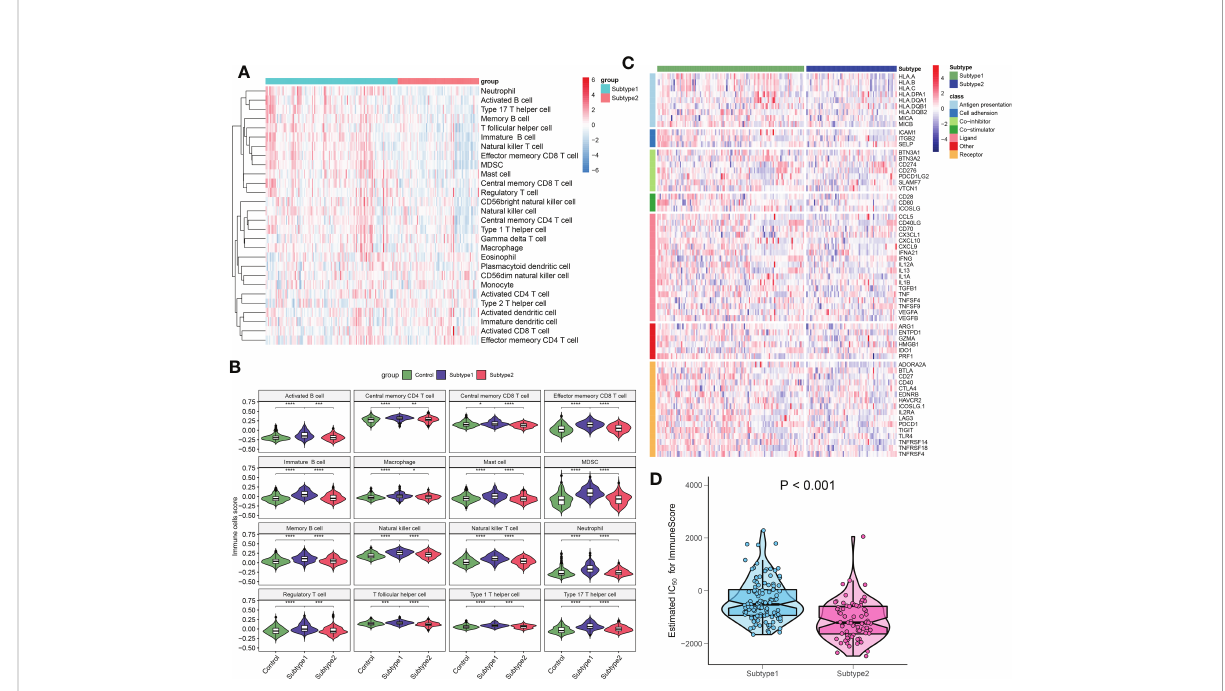
FIGURE 10 The immune characteristics of distinct immune microenvironment subtypes. (A) Heatmap showing the ssGSEA scores of 28 immune cell subpopulations between subtypes. (B) Violin diagram showing the differences of in fi ltrated immune cells among three groups. (C) Heatmap showing the differences in immune regulatory genes between subtypes. (D) Violin plots revealing the differences in immune scores between subtypes. *p < 0.05, **p < 0.01, ***p < 0.001, and ****p <